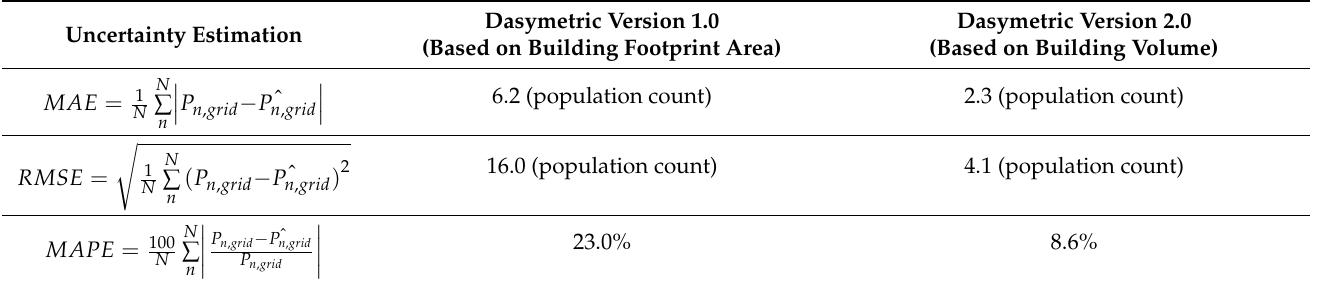
Table 7. Uncertainty estimations for the previous dasymetric mapping method [10] and the new improved method. Dasymetric Version 1.0 Uncertainty Estimation (Based on Building Footprint Area) 6.2 (population count) 2.3 (population count)